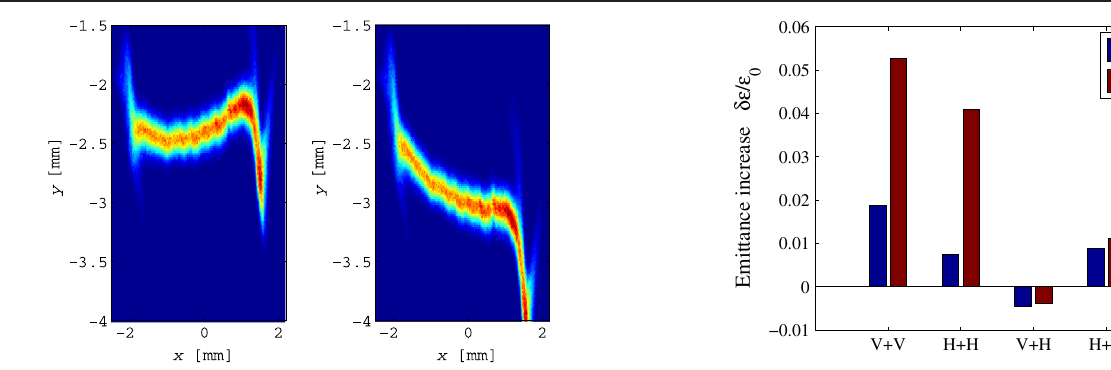
FIG. 10. Simulated images on the dump screen w = o (left) and w = (right) the dechirper wakefields with half-gap 2 a ¼ 1 . 4 mm. Bunch head lies at the left. The simulated images appear to have deviations with longitudinal phase space in Fig. 9 due to the wakefield effects of the undulator vacuum chamber.